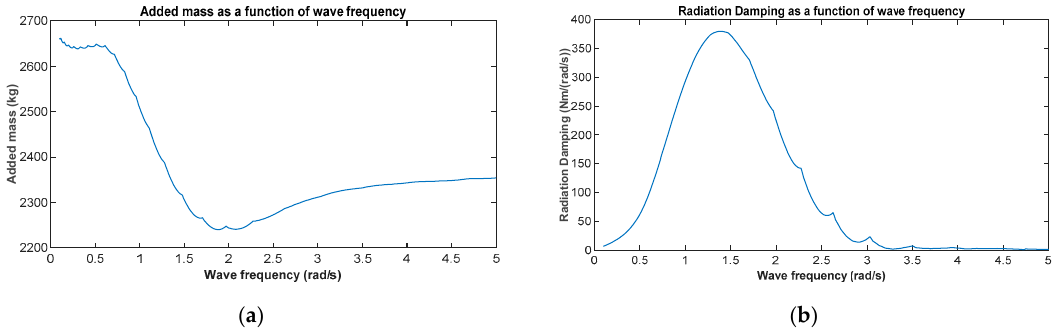
Figure 4. Hydrodynamic simulation outputs as a function of wave frequency for the cylindrical buoy of Figure 3: ( a ) Added mass; ( b ) Radiation damping. Table 1. Hydrodynamic and point absorber constant parameters for the cylindrical buoy under study.